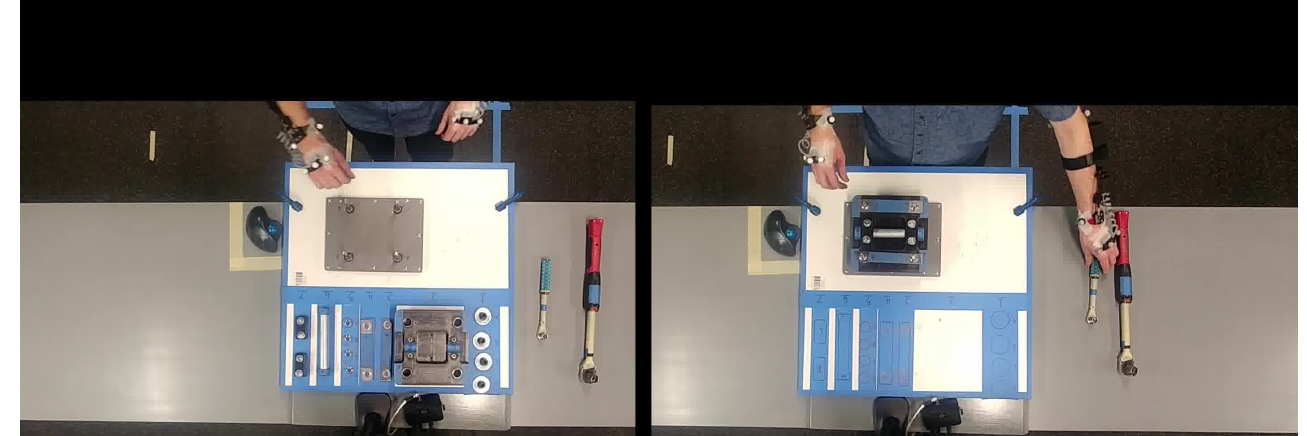
Figure 2. Assembly/disassembly task showing the disassembled apparatus ( left ) and assembled apparatus ( right ).